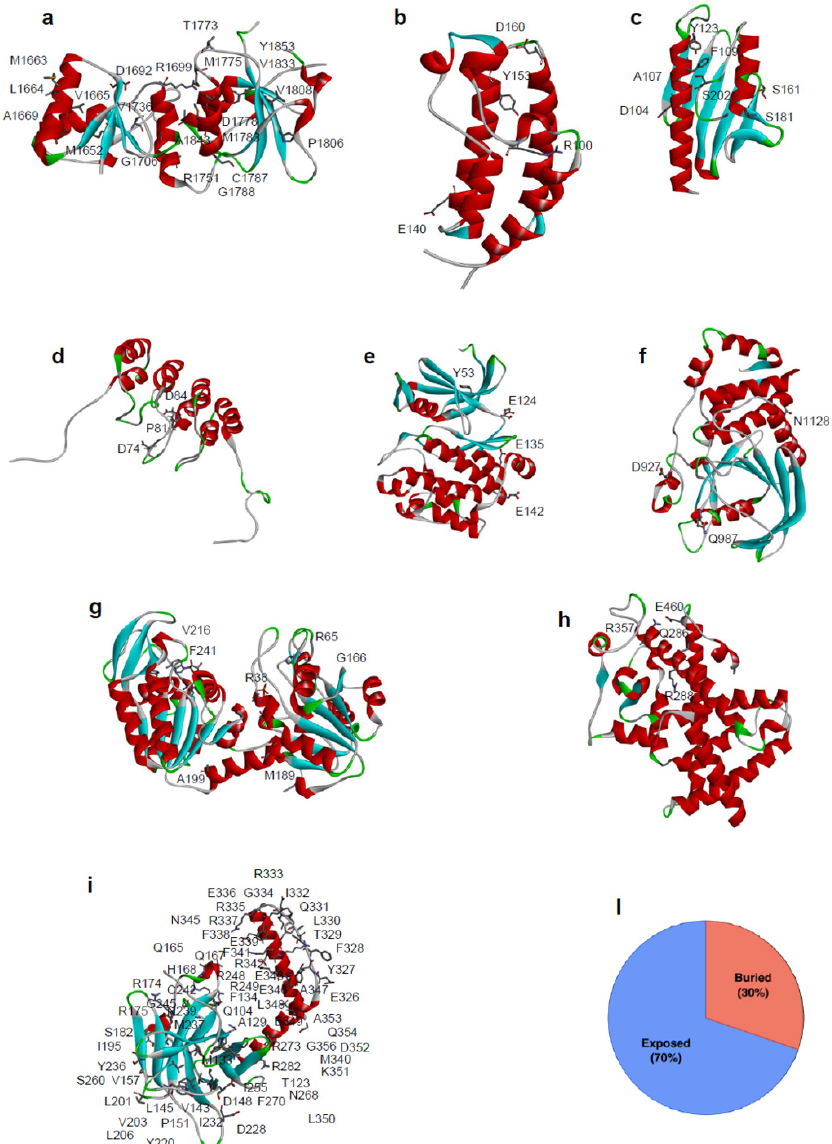
Figure 2. Location of SAVs analyzed in this review and their distribution based on the structural position of the mutated residues. Three-dimensional structure of the proteins analysed in this review are reported. ( a ) BRCA1 DNA repair associated protein (BRCA1) PDB code: 1JNX, ( b ) Bromodomain 2(1) (BRD) PDB code: 1X0J, ( c ) Frataxin (hFXN) PDB code: 1EKG, ( d ) p16 PDB code: 1DC2, ( e ) PIM-1 kinase PDB code: 1XWS, ( f ) Protein tyrosine phosphatase ρ (PTP ρ ) PDB code: 2OOQ, ( g ) Phosphoglycerate kinase 1 (PGK1) PDB code: 2XE7, ( h ) Peroxisome Proliferator Receptor γ (PPAR γ ) PDB code: 1PRG, ( i ) Tumor-protein p53 (p53) PDB code: 3Q01. Mutated residues in missense variants are depicted in stick. ( l ) Distribution of SAVs according to the structural position of the mutated residues for missense variants (30% of the mutation involved buried residues, 70% involved solvent exposed residues).